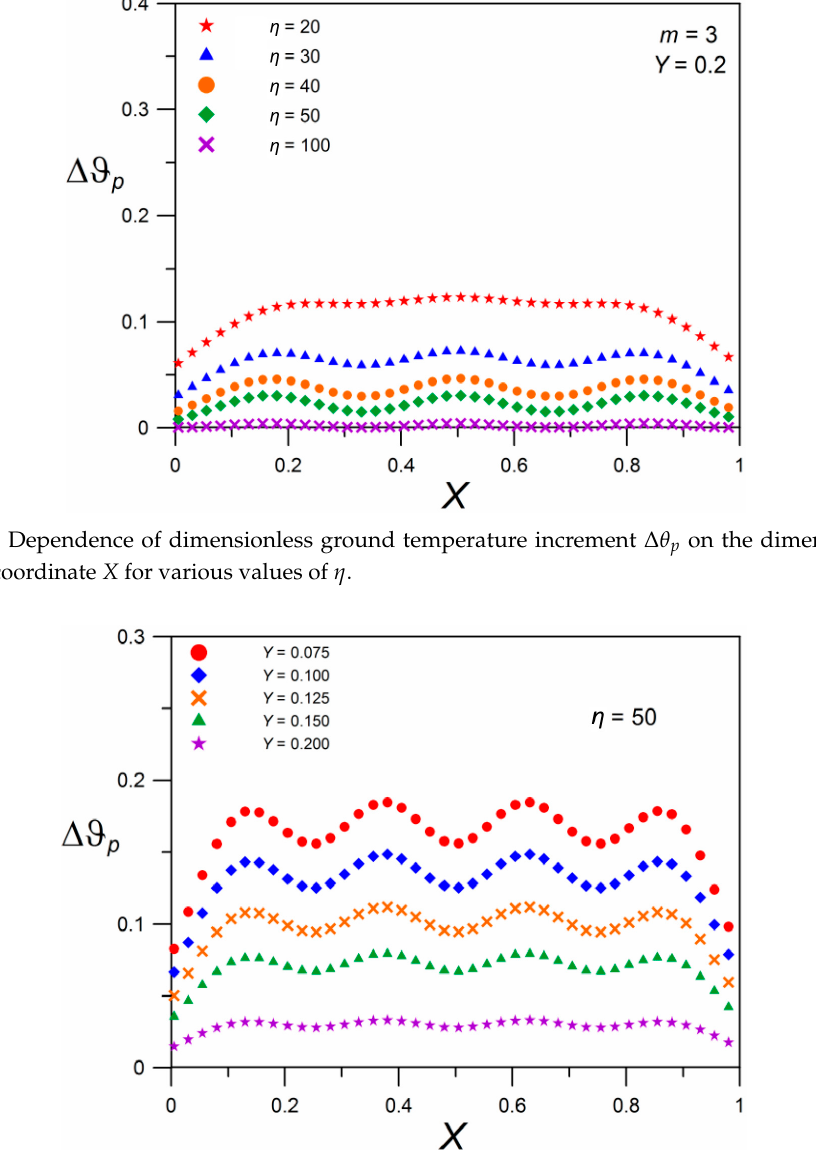
Figure 5. Dependence of dimensionless ground temperature increment ∆ θ p on the dimensionless position coordinate X for various values of Y.